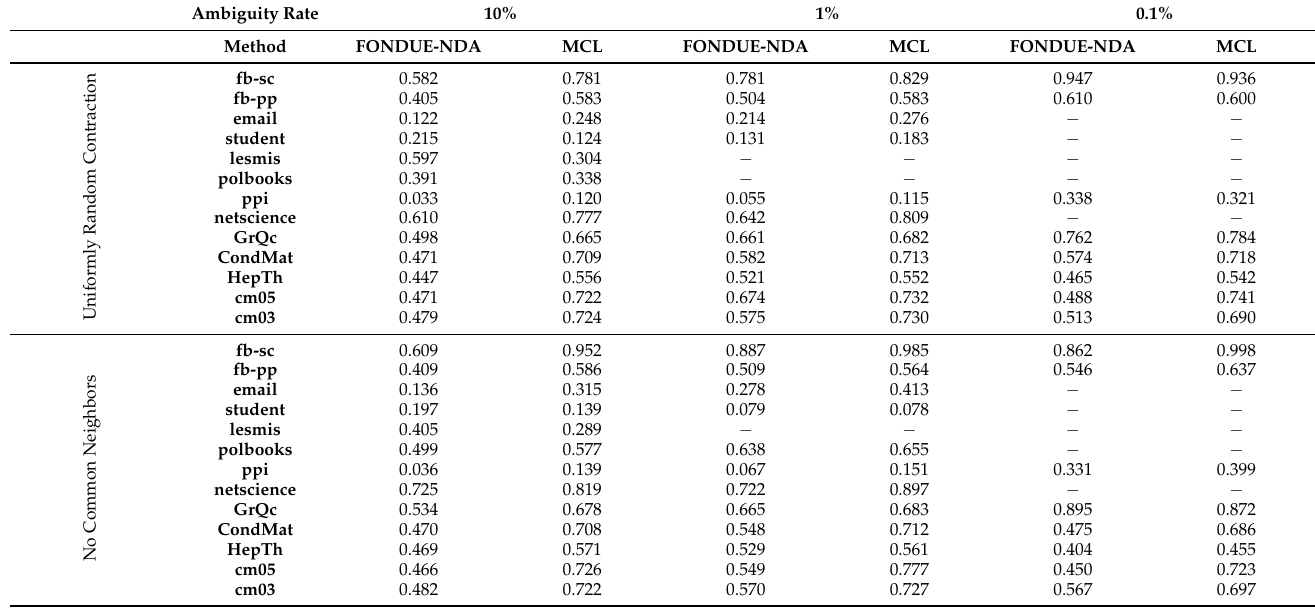
Table 6. Adjusted Rand index score for FONDUE-NDA and